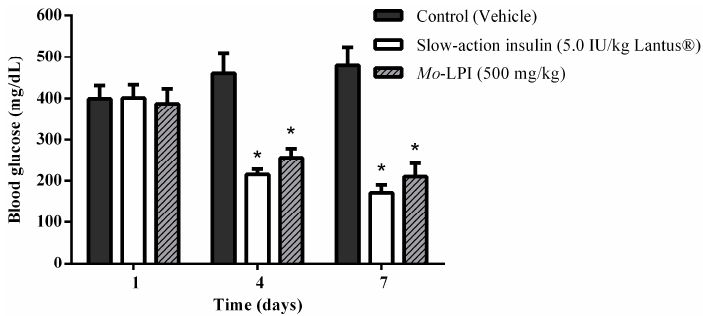
Figure 7. Effect of Mo -LPI on blood glucose level after seven consecutive days of intraperitoneal administration to alloxan-induced diabetic mice. Values are means ± S.E.M. ( n = 10). Control: vehicle (0.05 M Tris-HCl, pH 7.5, 0.15 M NaCl). * Significant ( p < 0.01) difference when compared with the corresponding value of the diabetic control.